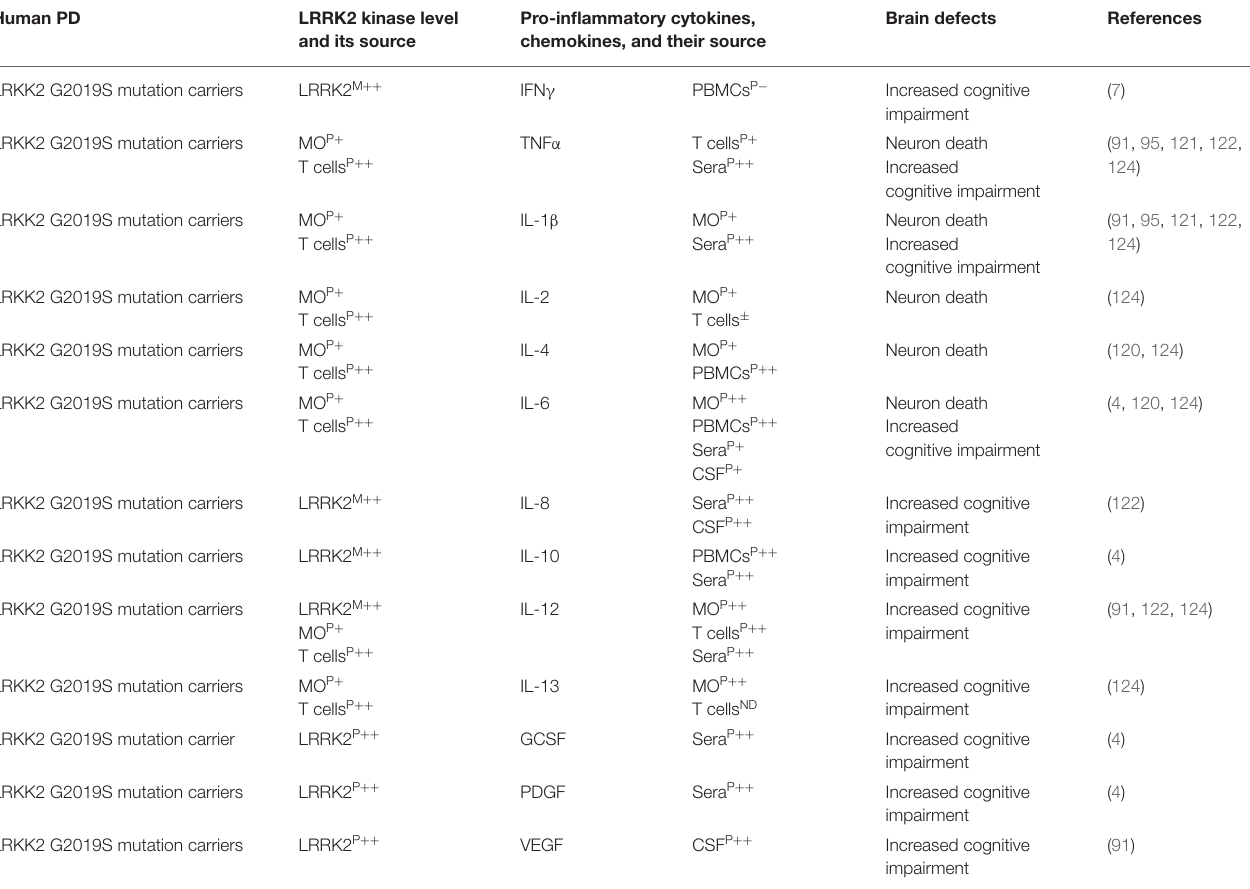
TABLE 2B | Cytokines and their source in the LRRK2-associated human PD. Human